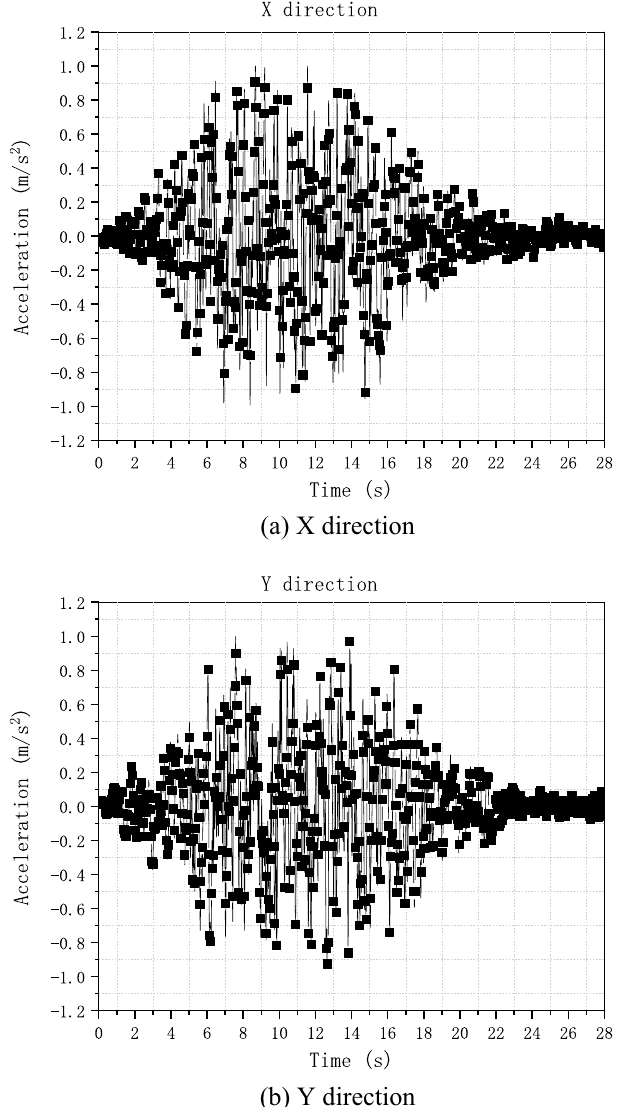
Figure 18. Artificial input earthquake in X and Y direction. ( a ) X direction, ( b ) Y